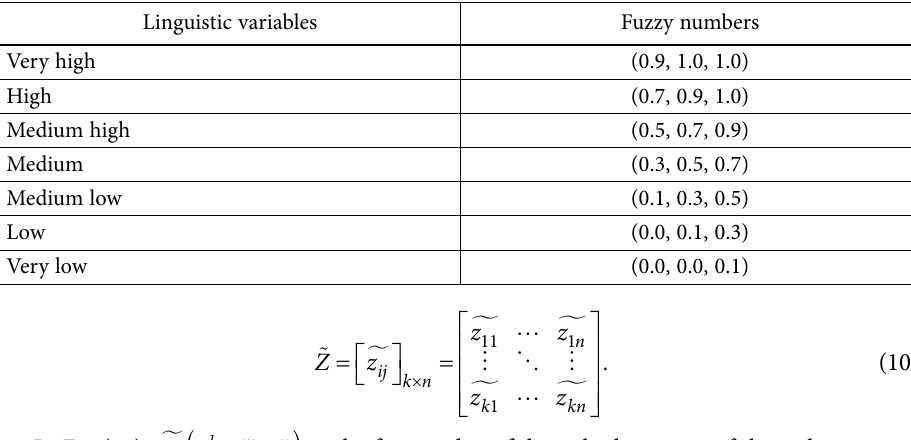
Table 3. The linguistic variables and fuzzy numbers (Stanujkic, 2015) Linguistic variables Fuzzy